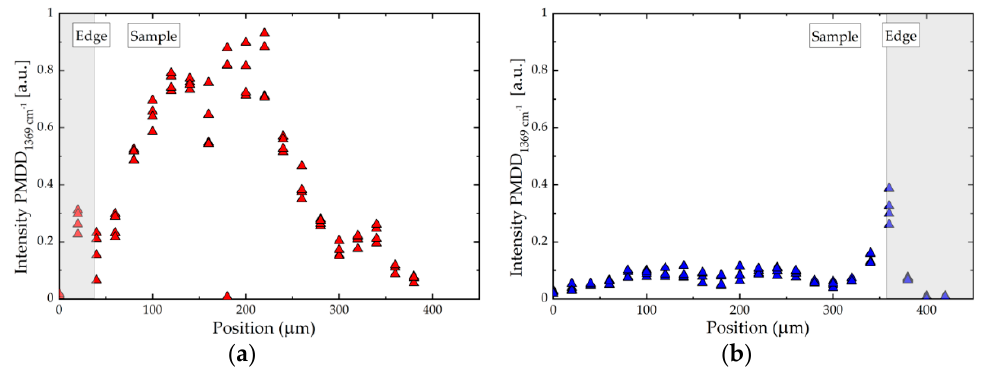
Figure 7. PMMD intensity for ( a ) PLA_4_200k and ( b ) PLA_0_94k as a function of position in the sample. Dark areas highlighted on the plots correspond to the air–sample interface. sample. Dark areas highlighted on the plots correspond to the air–sample